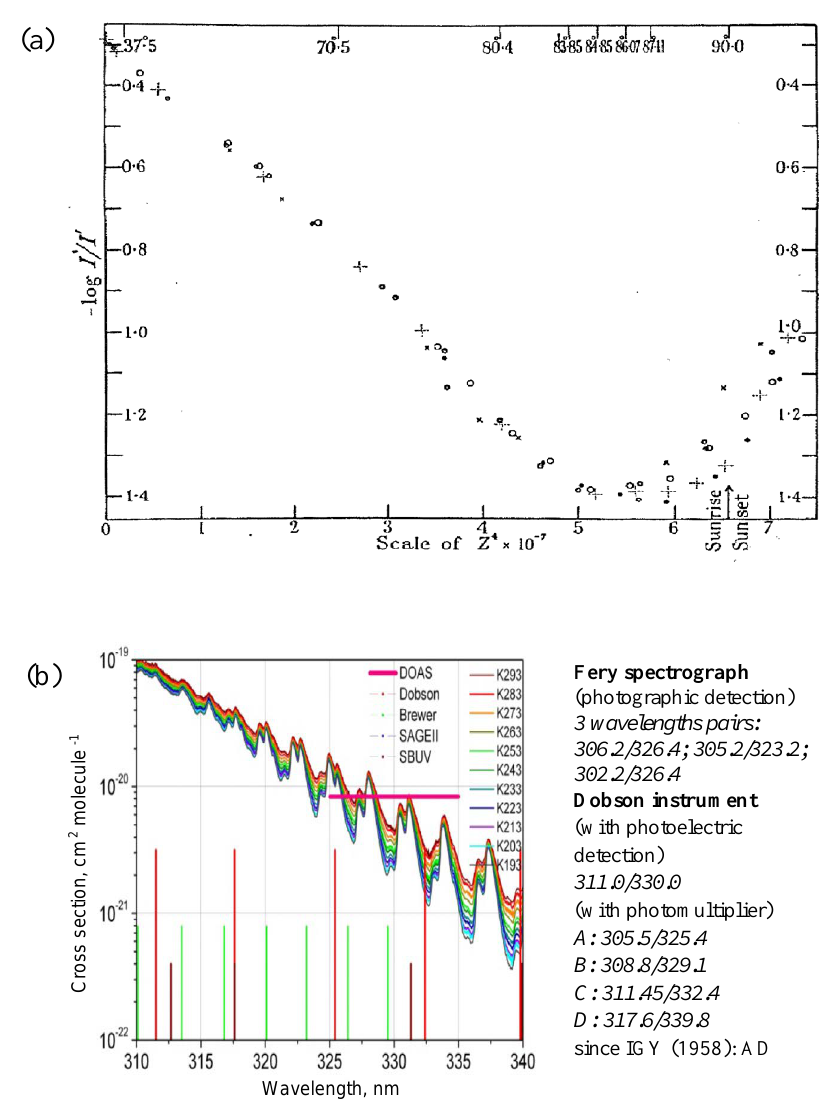
Figure 5. Ozone observations made using instruments designed by Dobson. (a) The Umkehr curve (Götz et al., 1934) used for ozone profile determination: zenith sky observation (determined by ozone absorption and scattering, wavelengths pair C) measured as a function of time covering sunrise or sunset (time represented by the solar zenith angle written at the top). When the sun reaches the lowest elevation angle the scattering at higher altitudes becomes predominant which causes the reversal (Umkehr). (b) Ozone absorption spectrum in the Huggins band (left, ACSO, 2015, Fig. 3) and wavelengths used in total ozone observation. AD wavelengths pairs used to minimise aerosol interference. The (World Primary) Dobson instrument is calibrated (extraterrestrial radiation) by the Langely plot